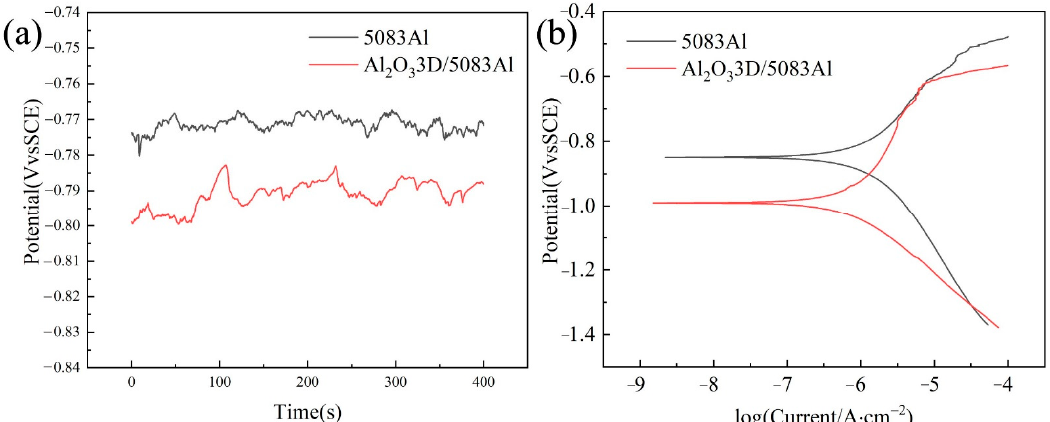
Table 2. Corrosion potential and corrosion current.